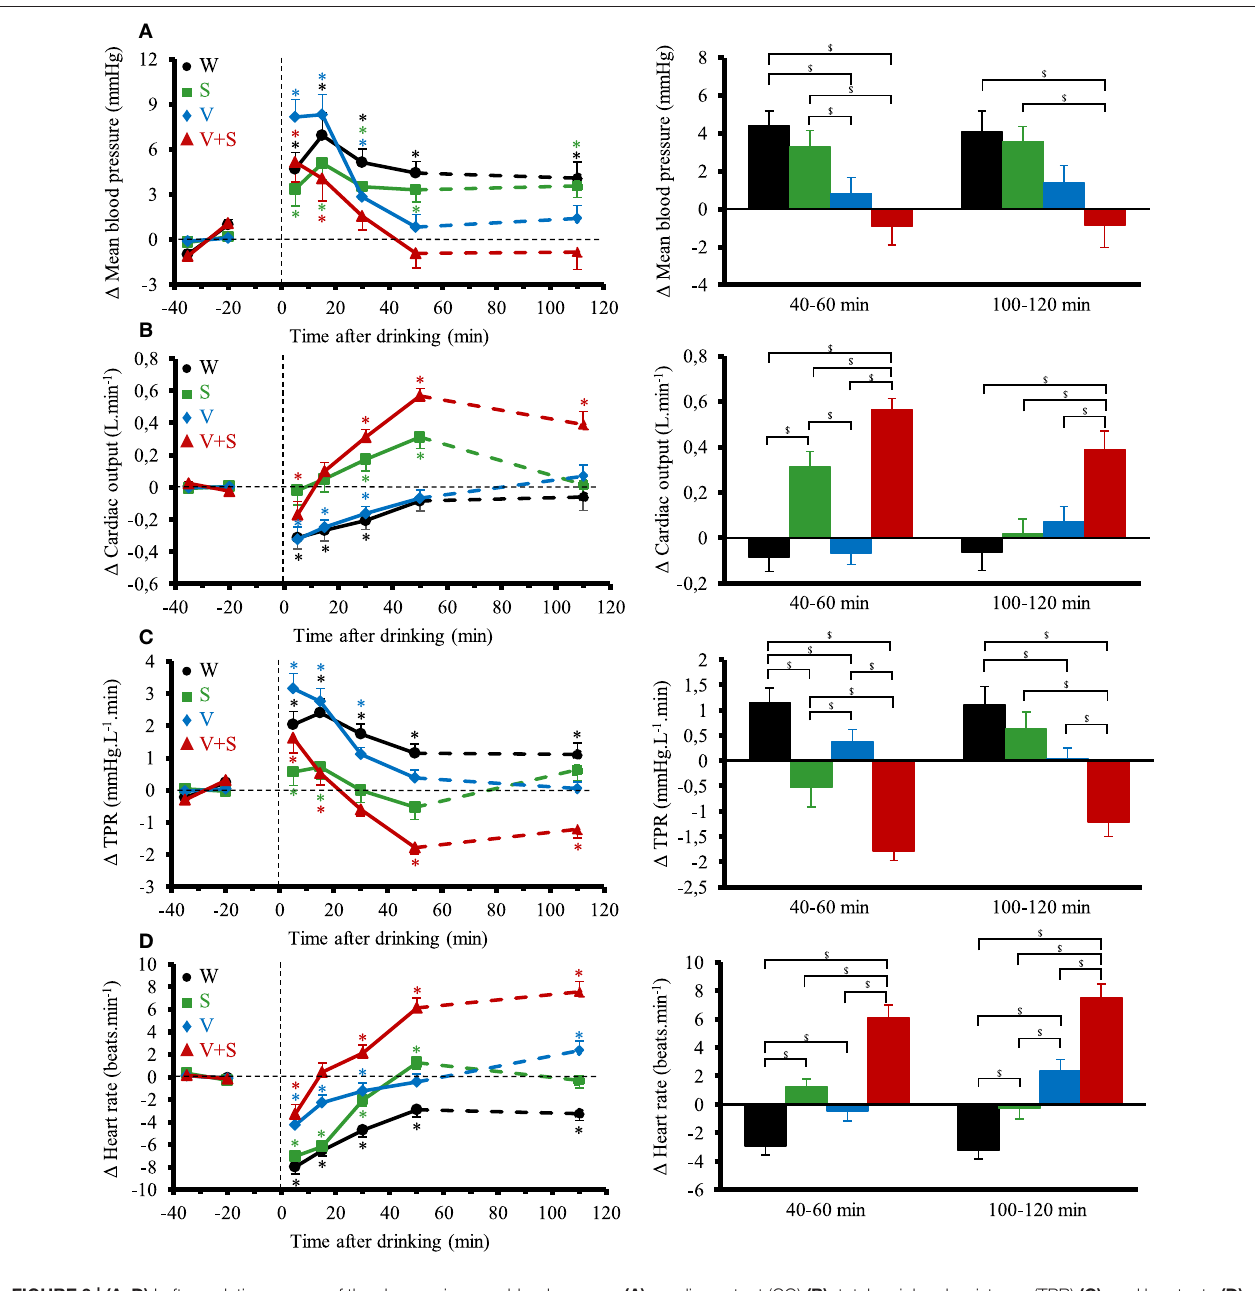
FIGURE 3 | (A–D) Left panel: time course of the changes in mean blood pressure (A) , cardiac output (CO) (B) , total peripheral resistance (TPR) (C) , and heart rate (D) . Right panel: mean responses averaged over 40–60 and 100–120min relative to baseline values and presented as a delta (i.e., average over 40–60 and 100–120min post-drink period, respectively, minus the average over the 30min baseline period). Drinks: water (W) , ; water + sugar (S) , ; water + vodka (V) , ; water + vodka + sugar (V + S) , . * p < 0.05 significant differences over time from baseline values; $ p < 0.05 significant differences between responses to the drinks.